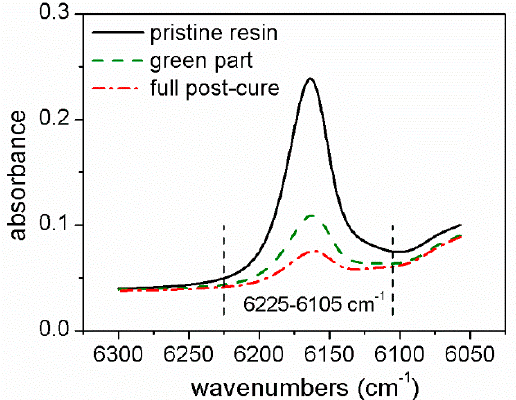
Figure 3. FT-NIR absorption band around 6225–6105 cm − 1 for DA-2 conversion calculation.